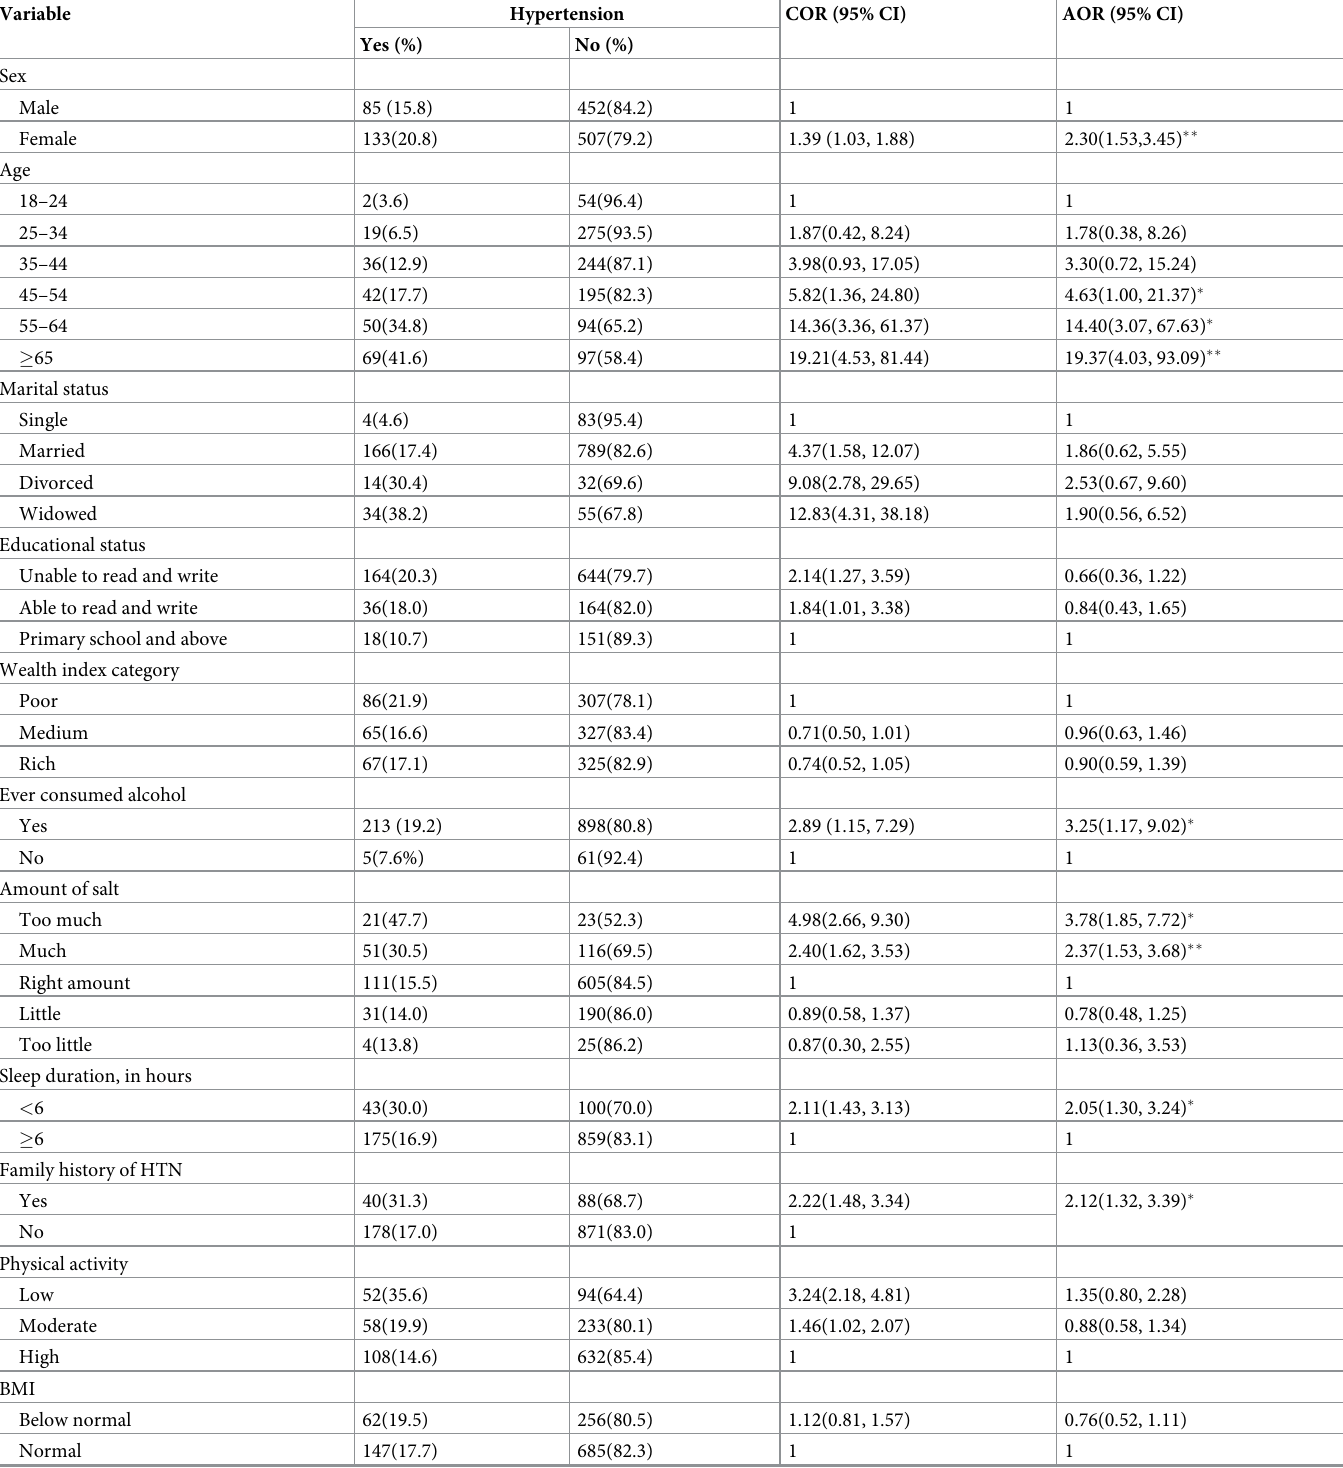
Table 3. Bivariate and multivariable logistic regression analysis of factors associated with hypertension in northwest Ethiopia, June-October